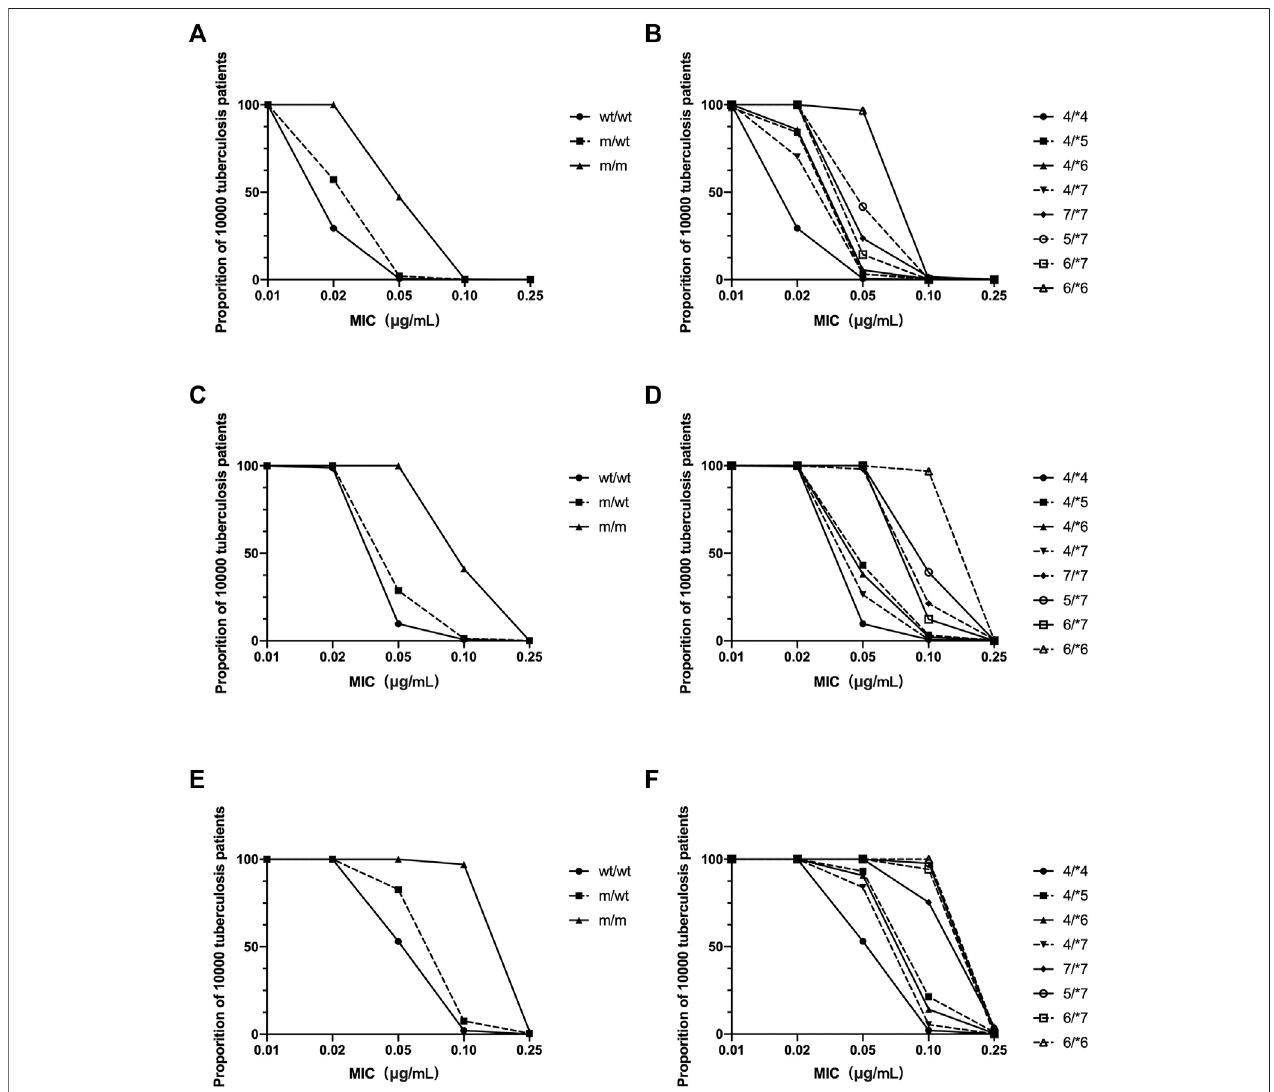
FIGURE 5 | The estimated probabilities of target attainment in patients with various NAT2 genotype and various doing regimens by a Monte Carlo simulation method.INHdosing regimen: 300 mgdaily (A,B) ;600 mgdaily (C,D) ;900 mgdaily (E,F) . (A,C,E) NAT2 genotype wascharacterizedashomogenouswildtype (wt/wt), heterozygous mutant (m/wt), and homogenous mutant (m/m). (B,D,F) NAT2 genotype was characterized according to various NAT2 alleles.